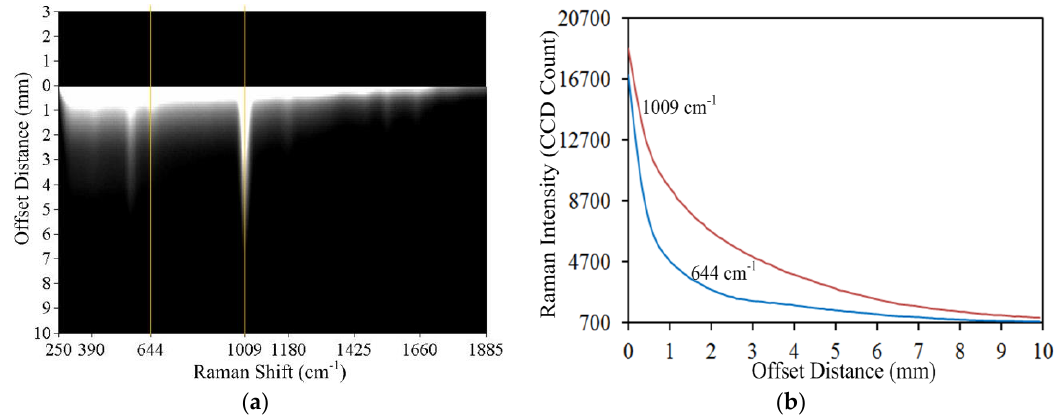
Figure 4. ( a ) Raman scattering image of capsule- urea sample; and ( b ) spatial profile of capsule (644 cm −1 ) and urea (1009 cm −1 ).